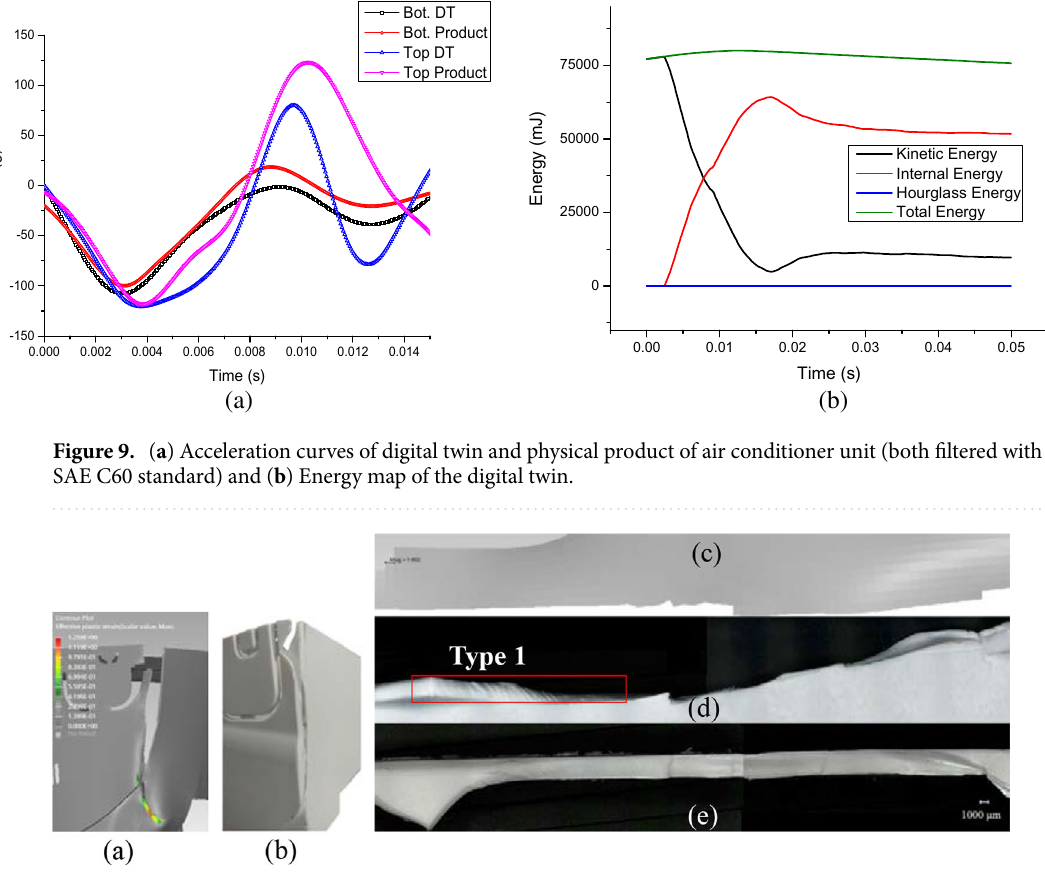
Figure 10. Fractured part ( a ) predicted by the digital twin, ( b ) photo-taken after drop test of physical product, main crack side-view profile ( c ) predicted by the digital twin, ( d ) photo-taken after drop test and ( e ) top view of crack under